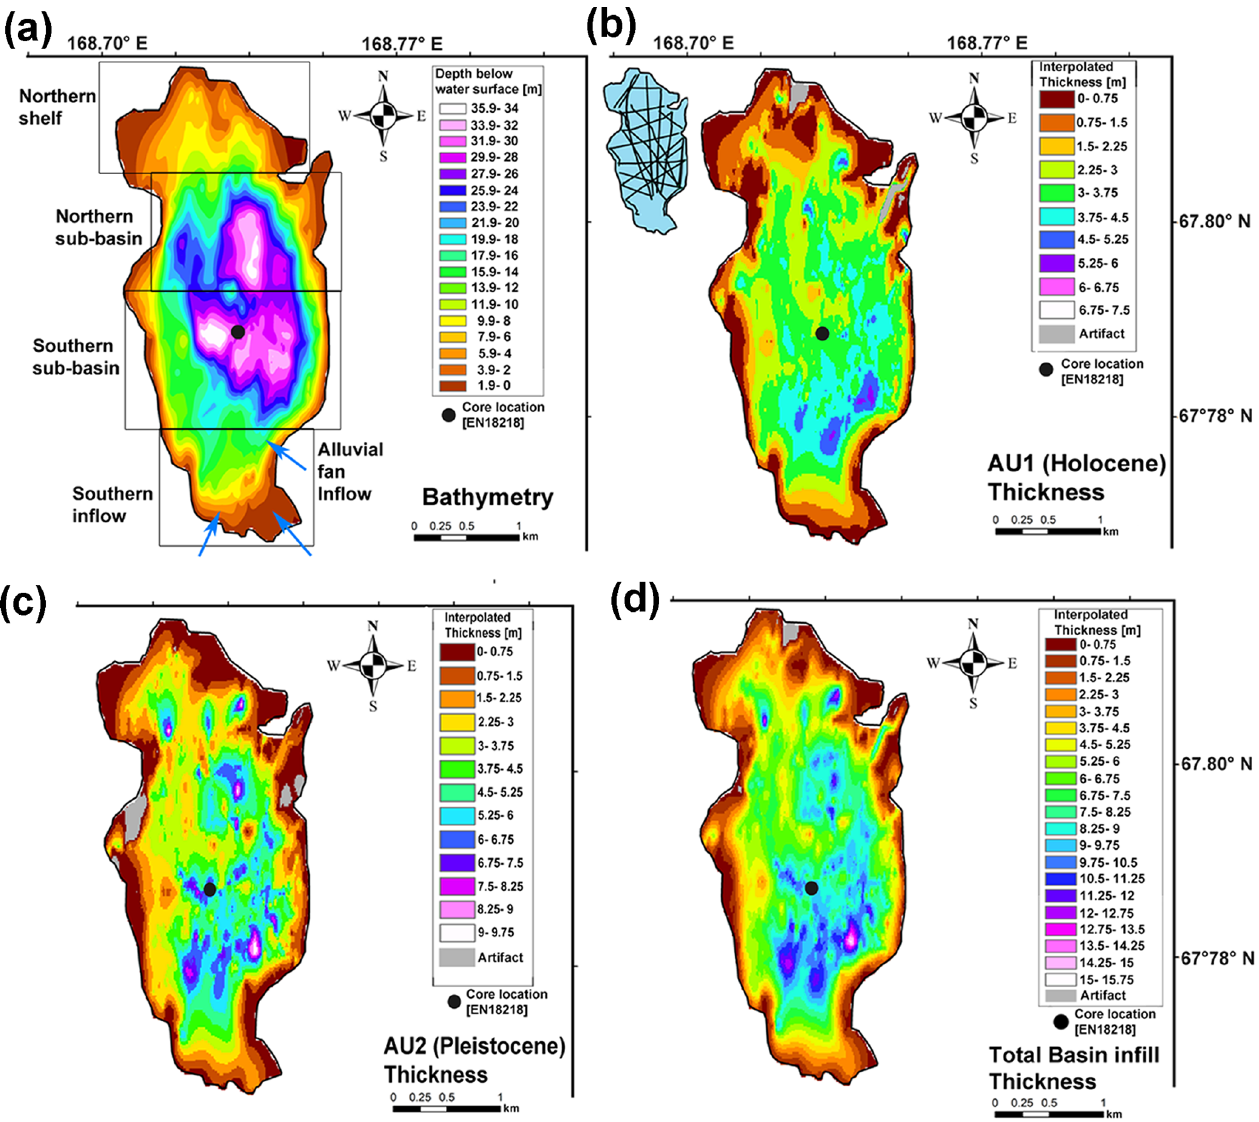
Figure 3. (a) Interpolated high-resolution lake bathymetry with morphological regions denoted by black boxes. (b) Interpolated AU1 thick- nesses. Blue and pink colours denote the thickest sediment within the southern sub-basin. (c) Interpolated sediment thicknesses within AU2. Similarly to AU1, the greatest thicknesses are predominantly located in the southern sub-basin but with other locations in the northern-sub basin showing thick sediments too. (d) Whole sediment package interpolated thickness. Thin sediment is found proximal to the basin margins and at the north-western shelf. The sediment distribution generally reflects sediment focussing into the deeper lake at greater water depths. Interpolation artefacts are attributed to data sparsity and difficulty in tracing reflectors in some regions due to acoustic blanking that led to erroneous interpolation. Larger artefacts were hence